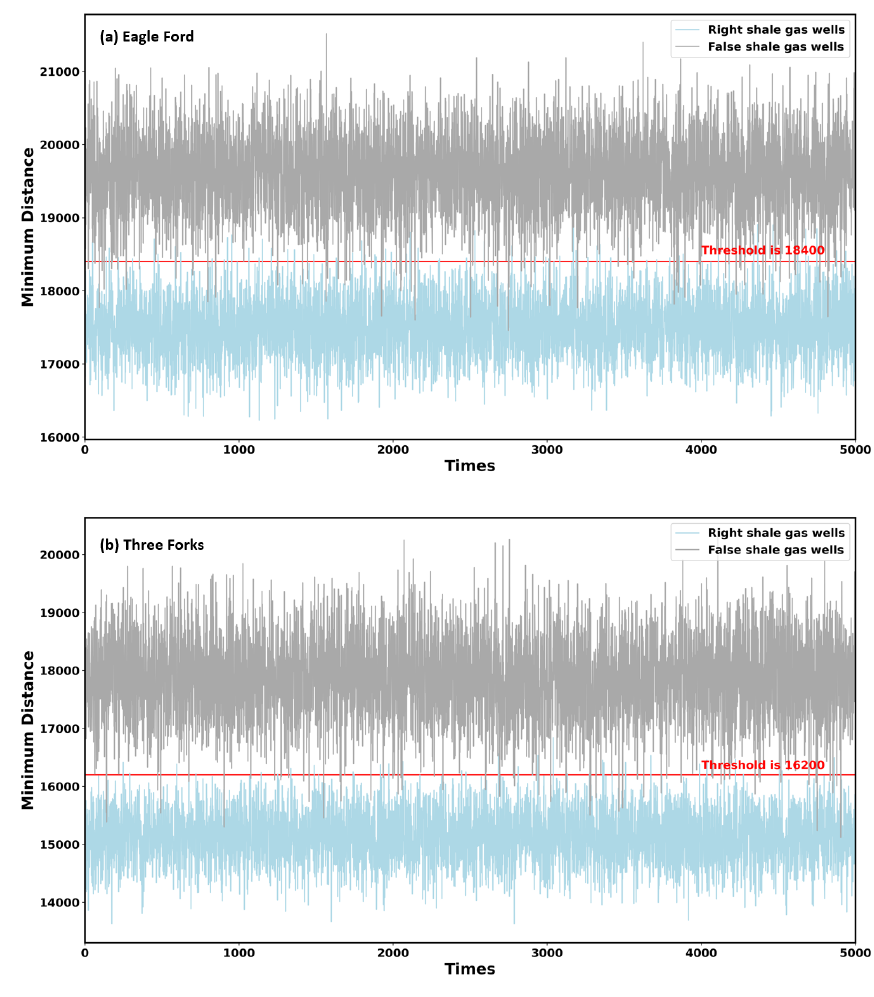
Figure 7. 5000 simulation calculations are used to determine the minimum distance